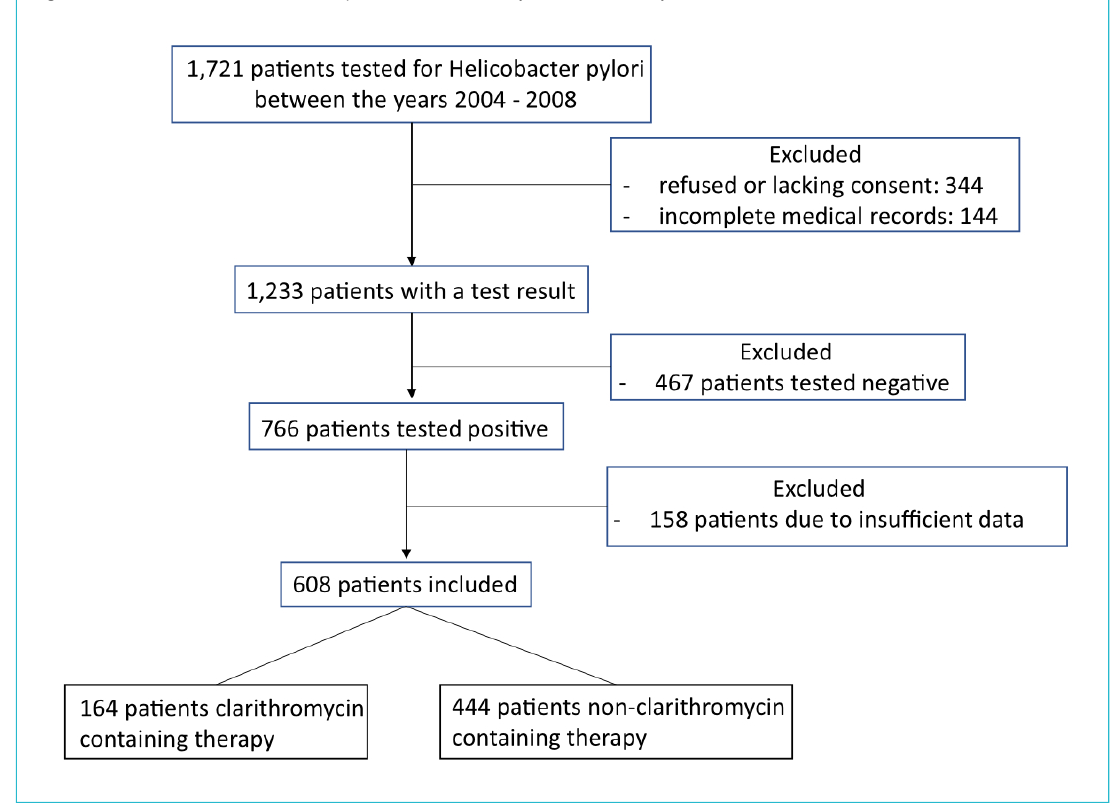
Figure 1: Overview of the total number of patients who were analysed and how many were included or